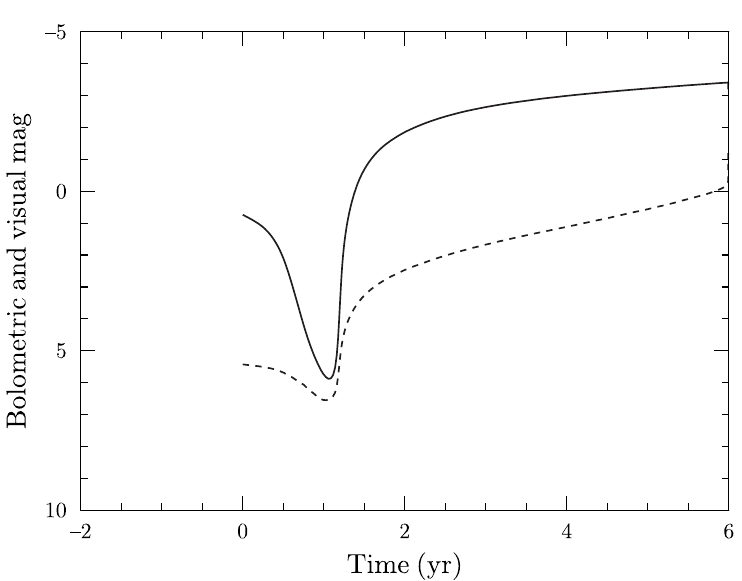
Fig. 7. This figure and the next three figures show the light curves for 4 of our 70 simulations. The WD mass and ˙ M are listed on the top of each figures. They are for four different masses but the same ˙ M , 3 (cid:2) 10 − 7 M ⊙ yr − 1 , and show that choosing an ˙ M in the middle of the ‘steady burning’ regime still results in a thermonuclear runaway. The dip before the final rise to maximum is explained in the text. Note that the simulation on the lowest mass WD, 0.4 M ⊙ , takes years to reach the peak while that on the highest mass WD, 1.35 M ⊙ takes less than one day.